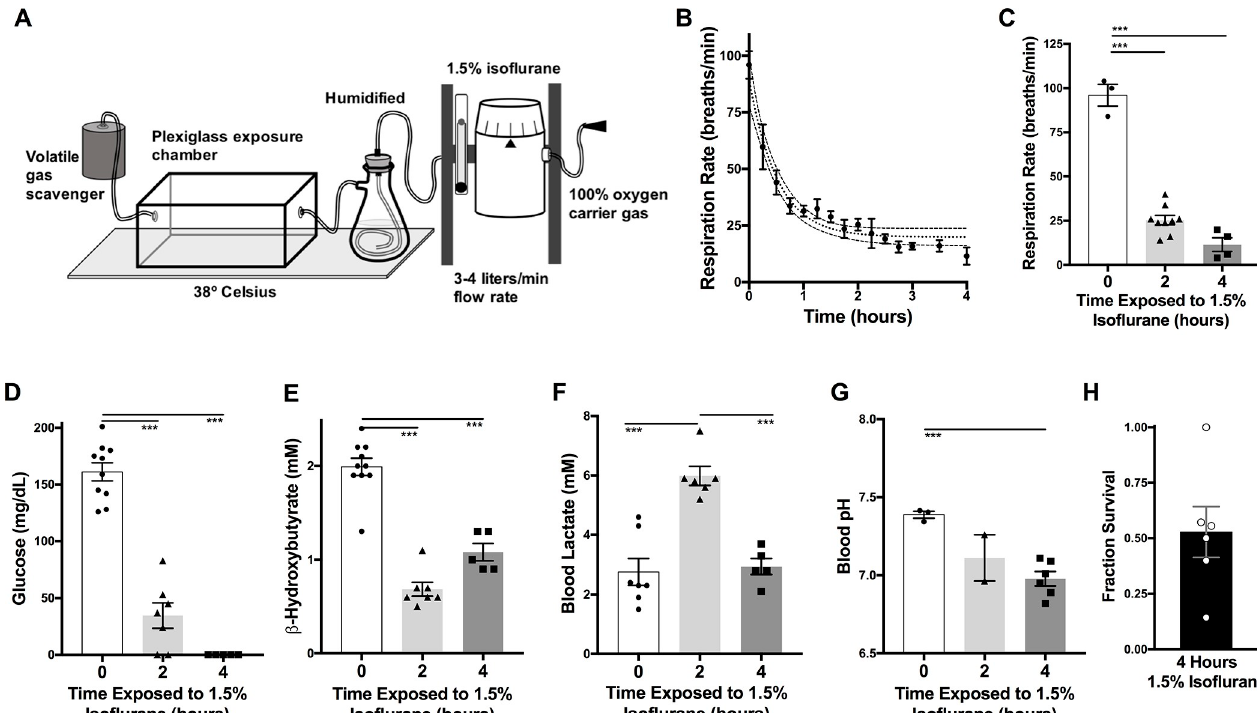
Fig 1. Physiological impact of prolonged anesthesia in P7 neonatal mice. ( A ) Experimental anesthesia setup. P7 neonatal mice were exposed to 1.5% isoflurane in 100% oxygen humidified air in a Plexiglass chamber, with gasses and chamber maintained at 38˚ C. ( B ) Respiratory rate in P7 mice as a function of time exposed to 1.5% isoflurane. Error bars depict standard error of the mean (SEM), dotted center lines depict non-linear best fit curve, dashed outer lines depict 95% confidence intervals (see Methods). n = 16 and 3 for 1.5% isoflurane and 1% isoflurane, respectively. ( C ) Comparison of respiratory rates in unexposed mice and mice anesthetized with 1.5% isoflurane for 2 or 4 hours ANOVA p-value < 0.0001; ���� p < 0.0001 post-hoc pairwise t-test. n = 13, 7, and 5 for 0, 2, and 4 hours of exposure, respectively. ( D ) P7 mouse blood glucose concentration at baseline and at 2 or 4 hours of anesthesia with 1.5% isoflurane ANOVA p-value < 0.0001; ���� p < 0.0001 post-hoc pairwise t-test. n = 13, 7, and 5 for 0, 2, and 4 hours, respectively. ( E ) P7 mouse blood ß-hydroxybutyrate concentration at baseline and at 2 or 4 hours of anesthesia with 1.5% isoflurane. ANOVA p-value < 0.0001; ���� p < 0.0001 post-hoc pairwise t-test. n = 10, 7, and 5 for 0, 2, and 4 hours of exposure, respectively. ( F ) P7 mouse lactate concentration at baseline and at 2 or 4 hours of anesthesia with 1.5% isoflurane. ANOVA p-value = 0.0007; ��� p = 0.0002, ���� p < 0.0001 post-hoc pairwise t-test. n = 7, 6, and 5 for 0, 2, and 4 hours of exposure, respectively. ( G ) P7 mouse blood pH at baseline and at 2 or 4 hours of anesthesia with 1.5% isoflurane. ANOVA p-value = 0.0007; ��� = p < 0.0005 post-hoc pairwise t-test. n = 3, 2, and 6 for 0, 2, and 4 hours of exposure, respectively. ( C-G ) Each data-point represents an individual animal. Error bars depict SEM. ( H ) Fraction of P7 mice surviving recovery period following exposure to 1.5% isoflurane for 4 hours. Data-points represent individual litters exposed for 4 hours, error bars represent SEM. Data represents a total of 6 litters (individual data-points) containing 4, 9, 3, 7, 7, and 5 pups, respectively. Total n = 35. � p = 0.0057 by one-sample t-test compared to a hypothetical value of